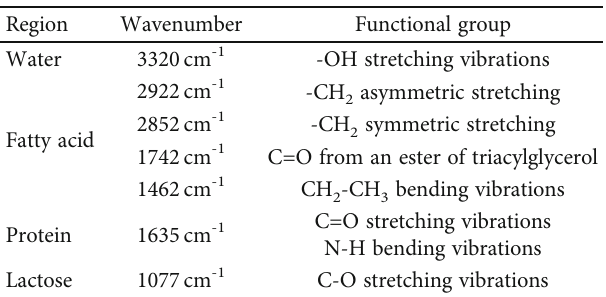
Figure 2: FTIR spectra of pure horse milk (HM), goat milk (GM), cow milk (CM), and ternary mixture (HM, GM, and CM) were scanned using attenuated total re fl ectance (ATR) mode in the infrared region (4000-650cm -1 ). Table 2: IR absorption of common bands detected in